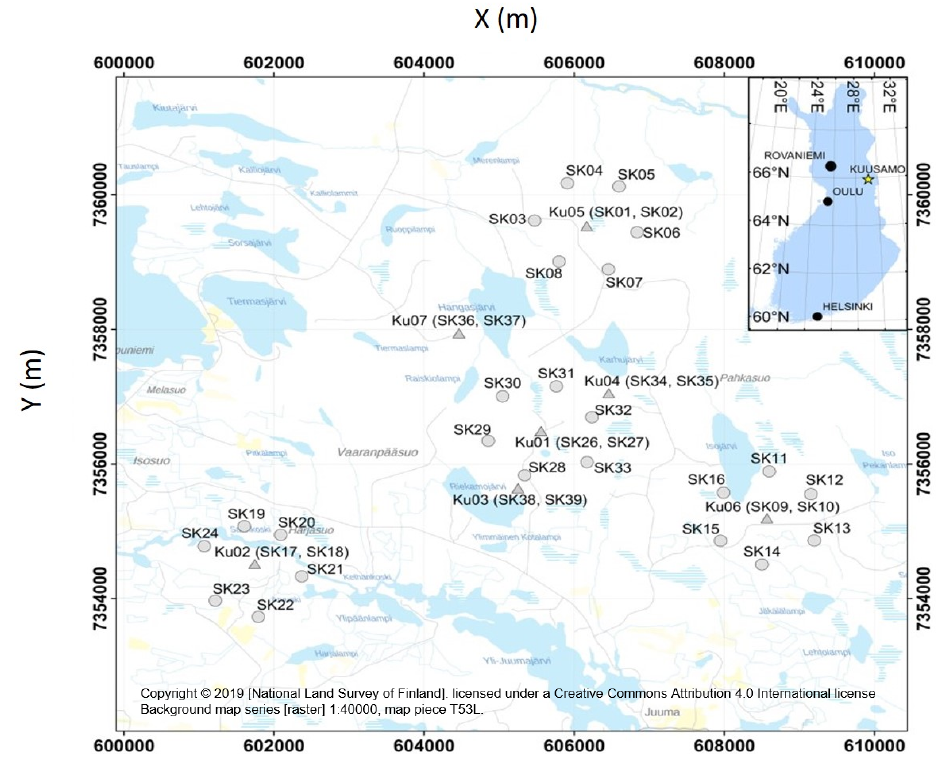
Figure 2. Configuration of the temporary seismic array on Kuusamo area in Universal Transverse Mercator coordinate system: white triangles – positions of broadband sensors (Trillium compacts); white dots – positions of accelerometers (MEMS).